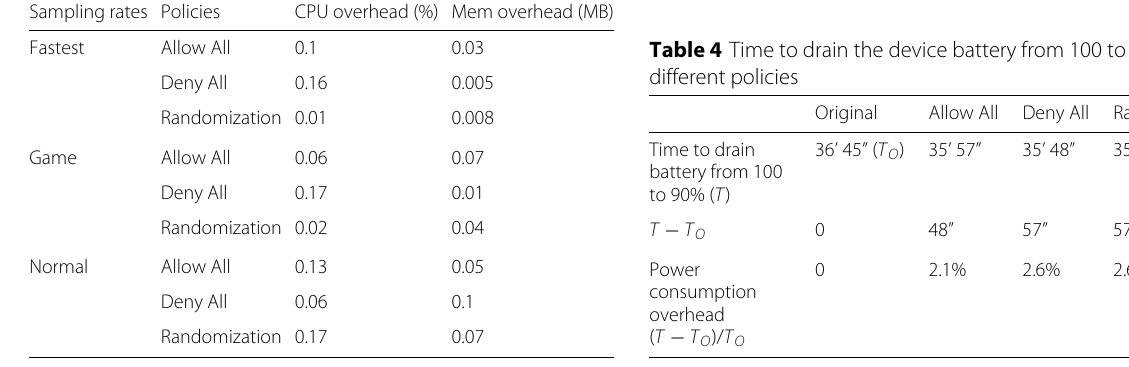
Table 3 CPU and memory overhead at different sampling rate and under different policies Sampling rates Policies